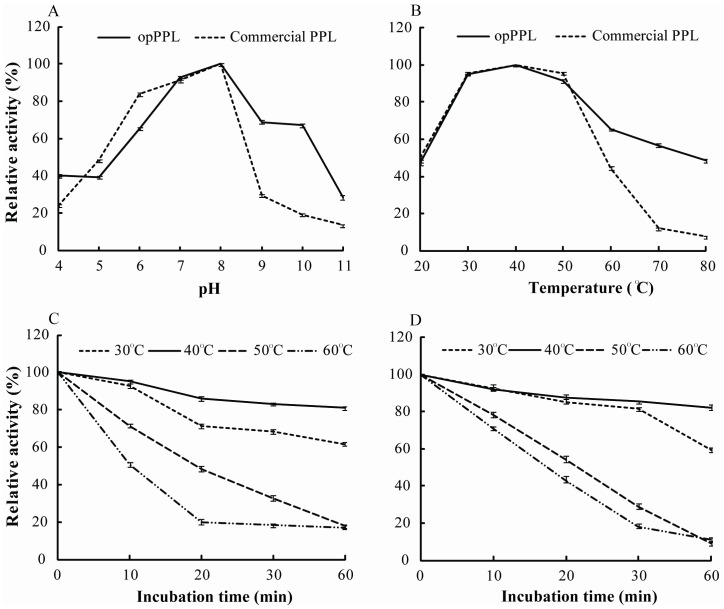
Comparison of opPPL and commercial PPL activity.(A) Effect of pH on the activity of opPPL and commercial PPL. (B) Effect of temperature on the activity of opPPL and commercial PPL.(C) The thermostability of commercial PPL. (D) The thermostability of purified opPPL. These assays were performed as described in Materials and methods using 10.0 mM p-NPP as substrate (n = 3). The maximum value was taken as 100%.